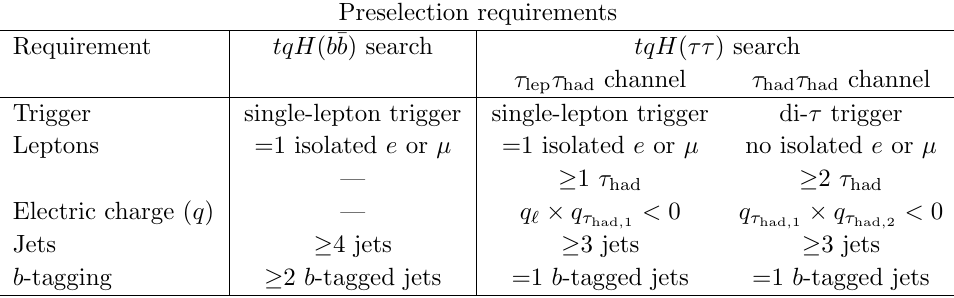
Table 1 . Summary of preselection requirements for the tqH ( b (cid:22) b ) and tqH ( (cid:28)(cid:28) ) searches. The leading and trailing (cid:28) had candidates are denoted by (cid:28) had ; 1 and (cid:28) had ; 2